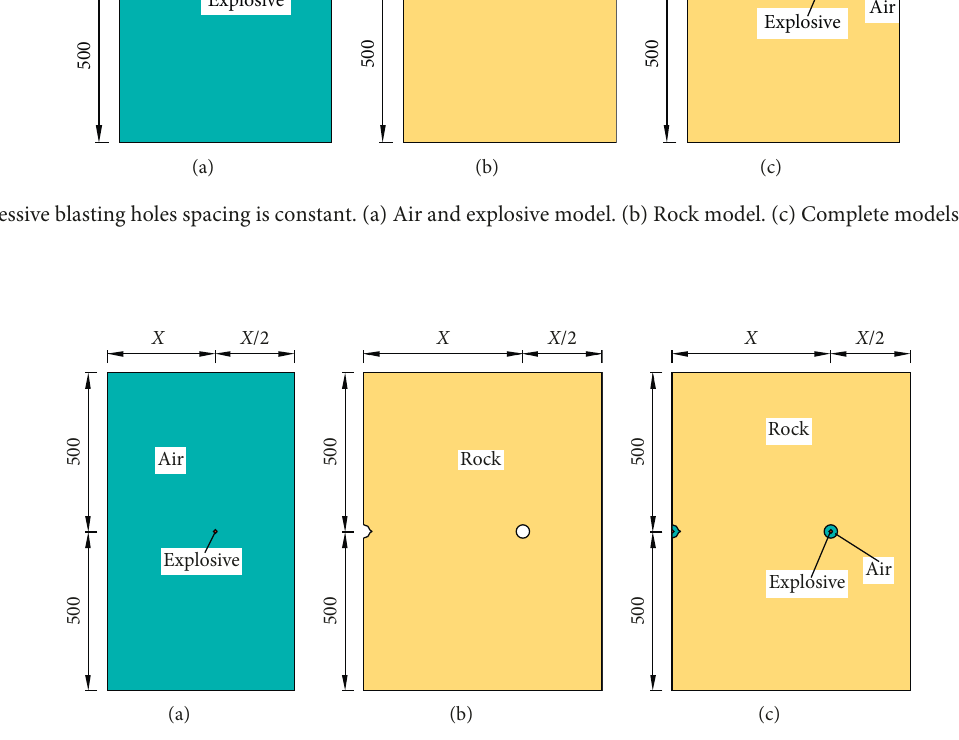
Figure 5: Successive blasting holes spacing is changed. (a) Air and explosive model. (b) Rock model. (c) Complete models of air, explosive, and